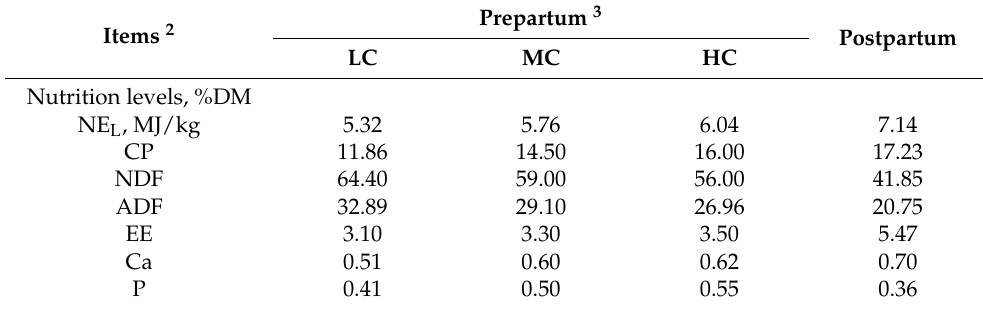
Table 2. Average nutrient ingredients 1